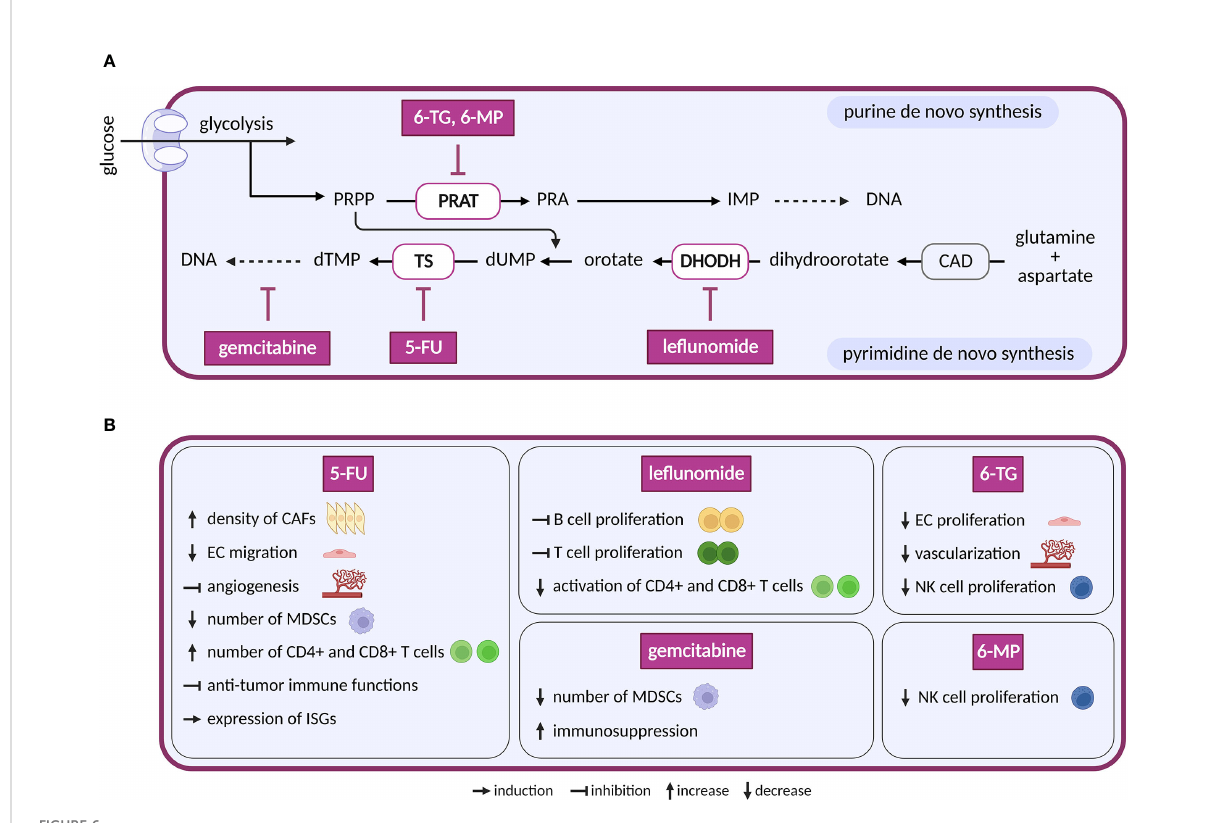
FIGURE 6 Inhibitors of nucleotide metabolism and their effects on TME cell types. (A) Schematic representation of nucleotide de novo synthesis. Anti- nucleotide therapy compounds with a reported effect in the TME are shown. These compounds are in clinical trials for cancer or in clinical use. (B) Diverse effects of the nucleotide inhibitors shown in (A) on cell populations present in the